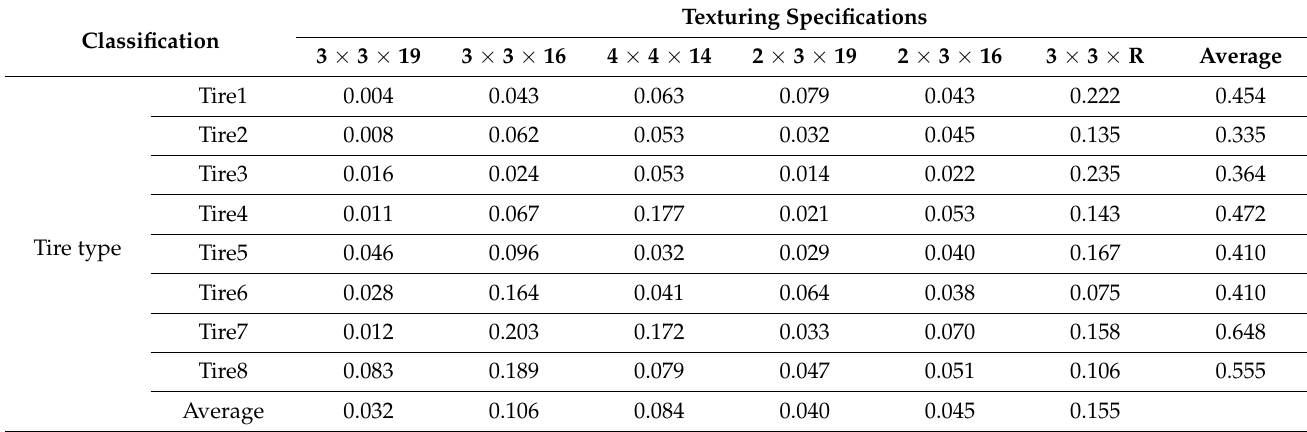
Table 5. Lateral vibration occurrence rate (acceleration